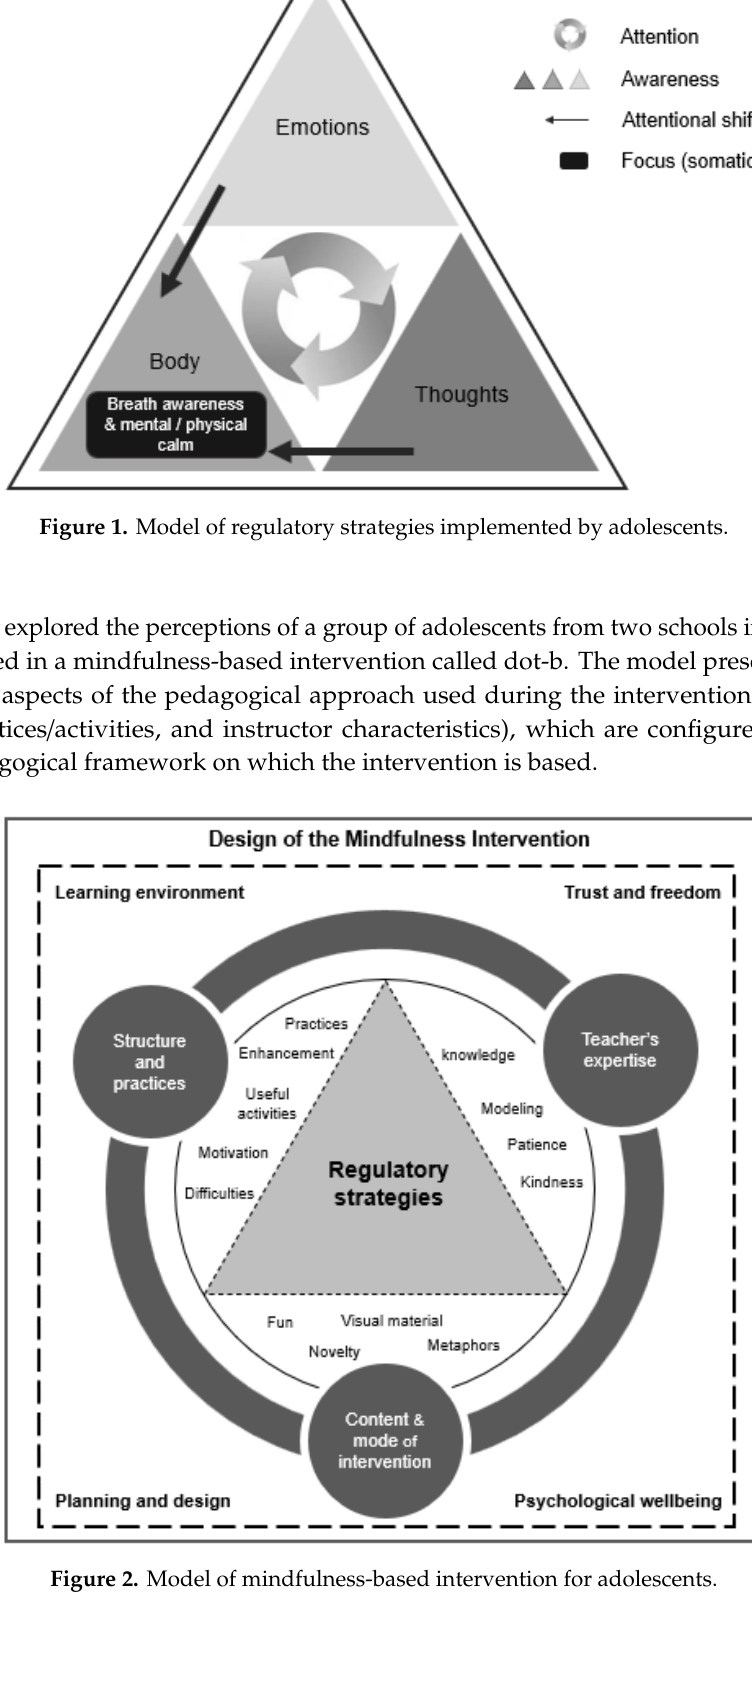
Figure 2. Model of mindfulness-based intervention for adolescents.